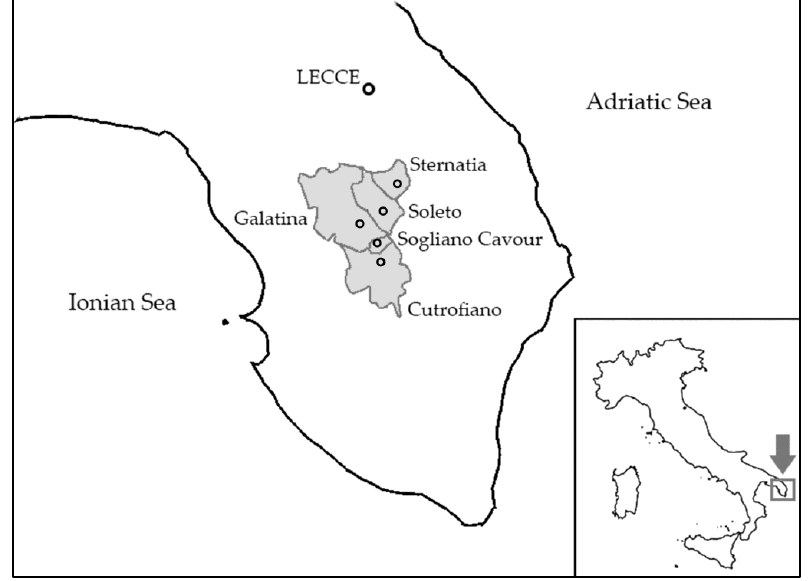
Figure 1. Map of the Salento Peninsula showing the location of the municipalities included in the IMP.AIR study and their administrative area (in grey).